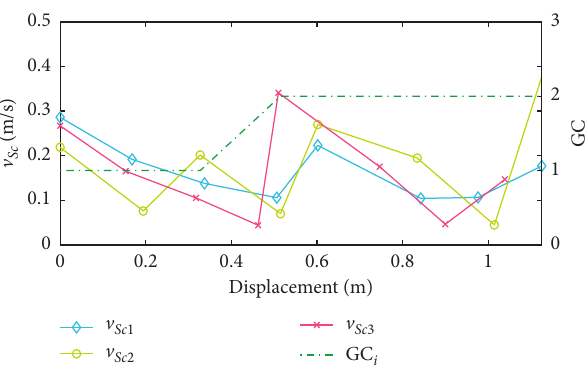
Figure 8: Average speed of each cycle.